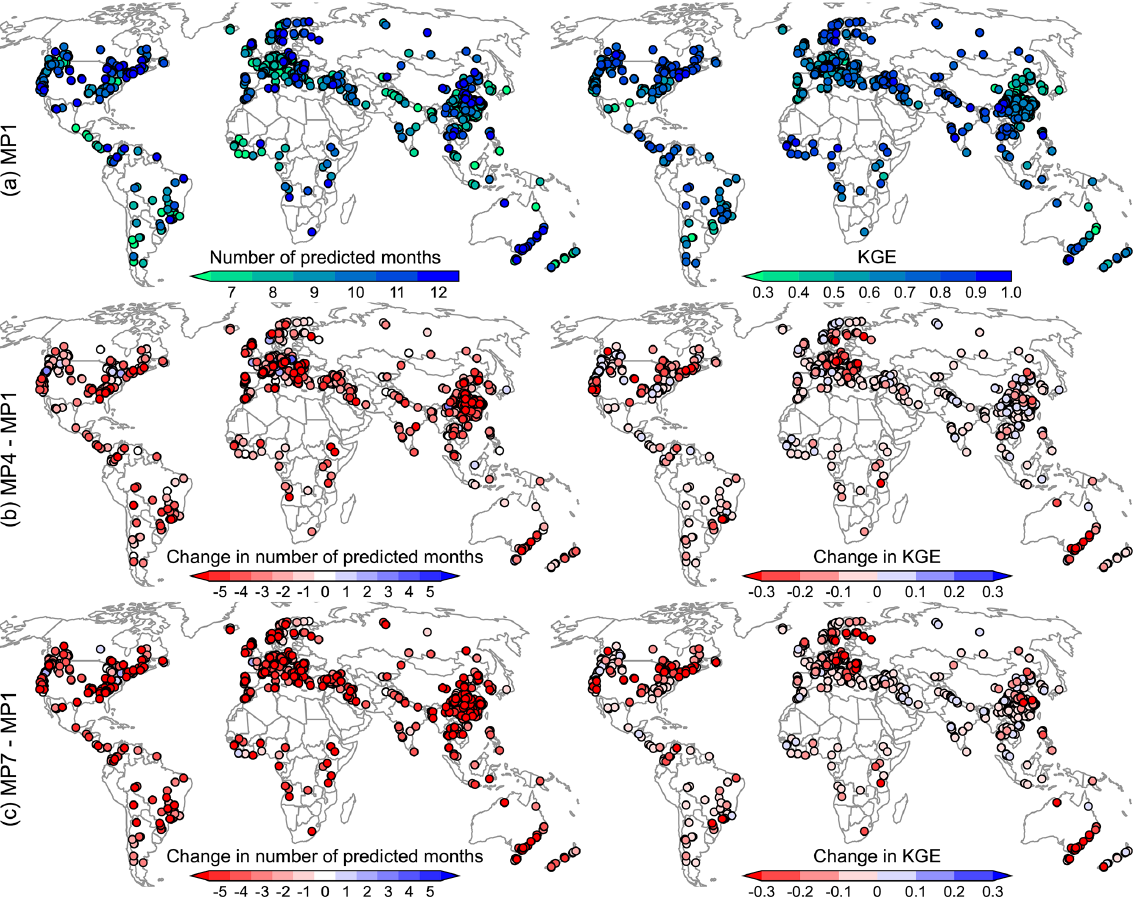
Figure 3. Number of months in which a predictive model is developed (left) and corresponding KGE (right). Taking a model with a lead-time of 1 month (MP1) as reference (a) , we report the difference between MP1 and MP4 (b) and MP1 and MP7 (c)